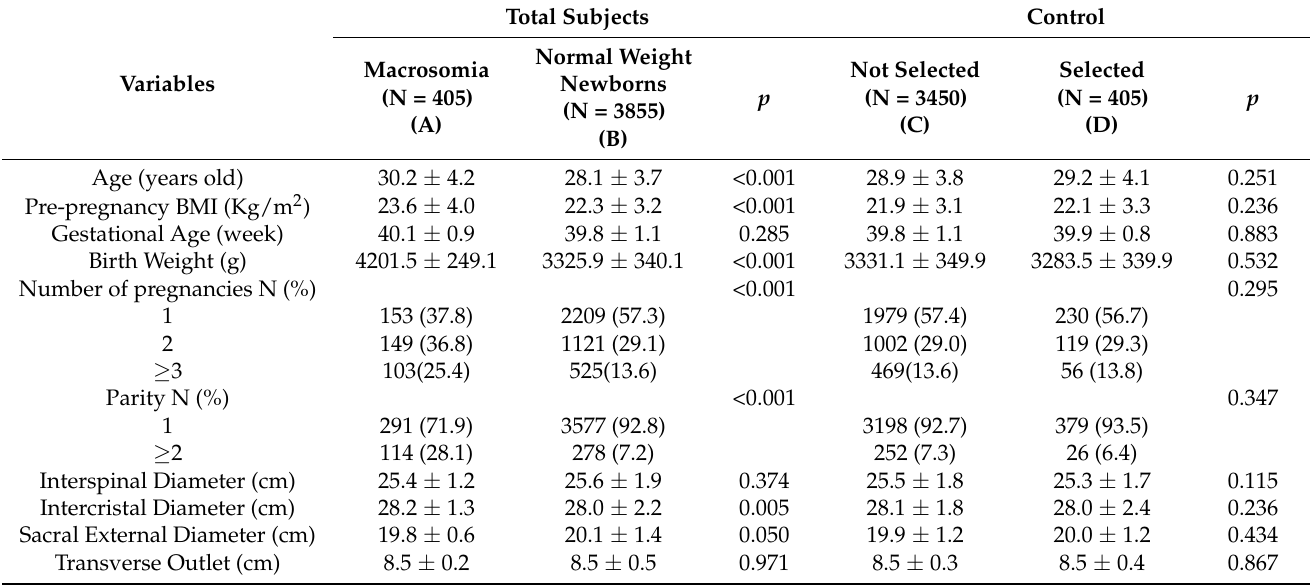
Table 1. Characterization of macrosomia and control groups and the representativeness of the